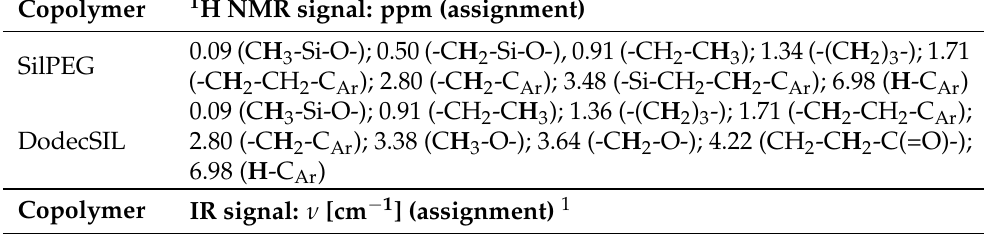
Table A1. Assignments of the main 1 H NMR and FT IR signals of SilPEG and DodecSIL.